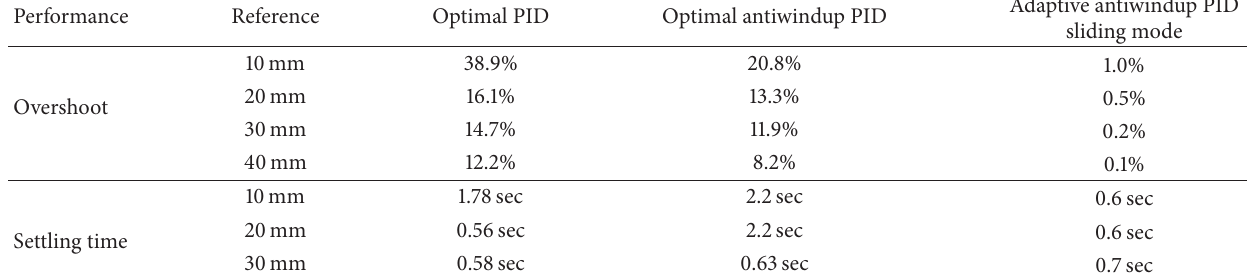
Table 4: Comparison of the performance of optimal PID, optimal antiwindup PID, and adaptive antiwindup PID sliding mode control systems without load disturbance.